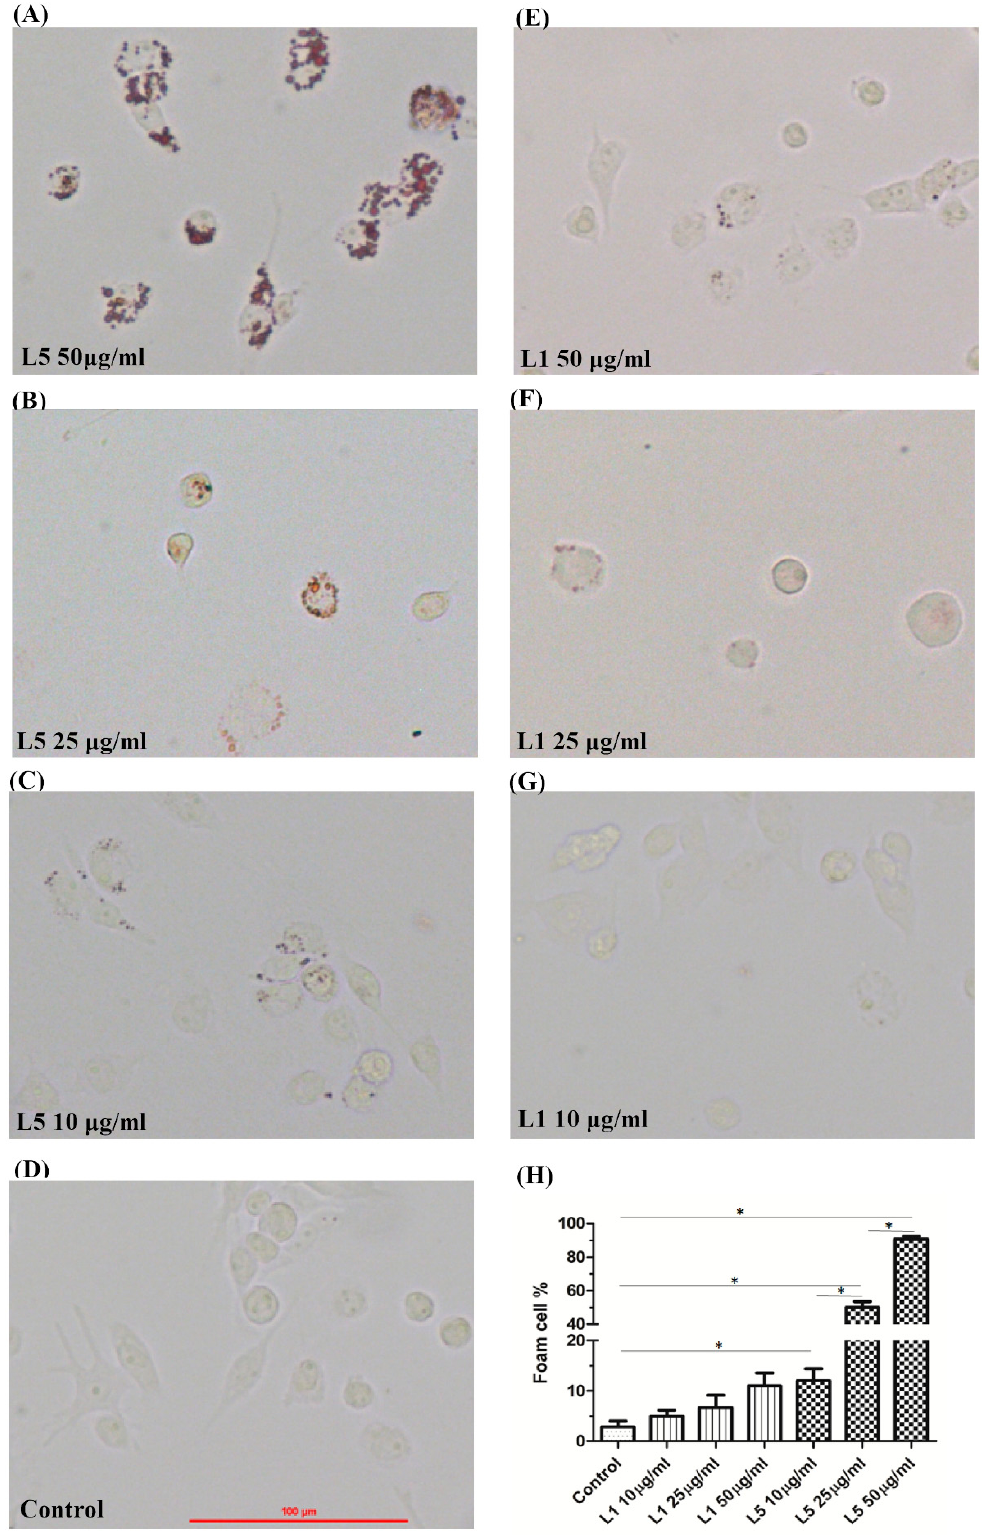
Figure 1. E ff ects of L5 on macrophage foam cell formation. THP-1 cells were incubated with ( A ) high-dose L5 (50 µ g / mL), ( B ) midden-dose L5 (25 µ g / mL), ( C ) low-dose L5 (10 µ g / mL), ( D ) control (phosphate bu ff ered saline, ( E ) high-dose L1 (50 µ g / mL), ( F ) midden-dose L1 (25 µ g / mL), and ( G ) low-dose L1 (10 µ g / mL) for 48 h. ( H ) Di ff erence in the proportion of macrophage foam cell formation among the di ff erent groups. Data are presented as the mean ± SEM for three independent experiments. * p < 0.05, determined by one-way